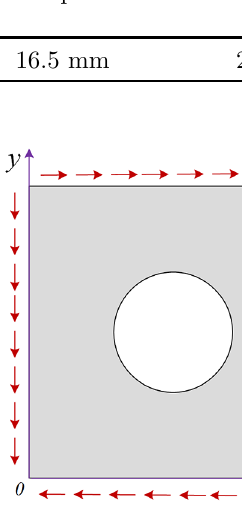
Fig. 2. Schematic diagram of shear condition of the perforated plate (taking circular perforated plate as an